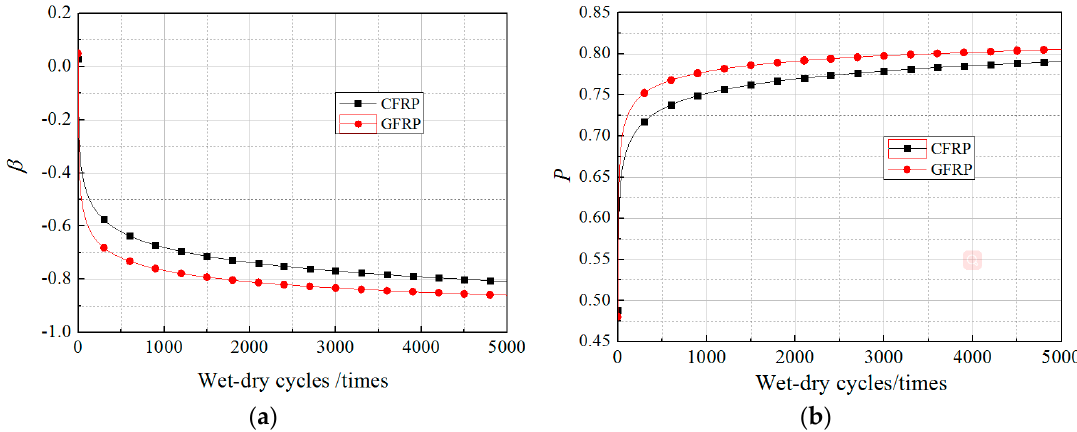
Figure 6. The parameters change as a function of wet-dry cycles: ( a ) Change of β ; and ( b ) change of P .